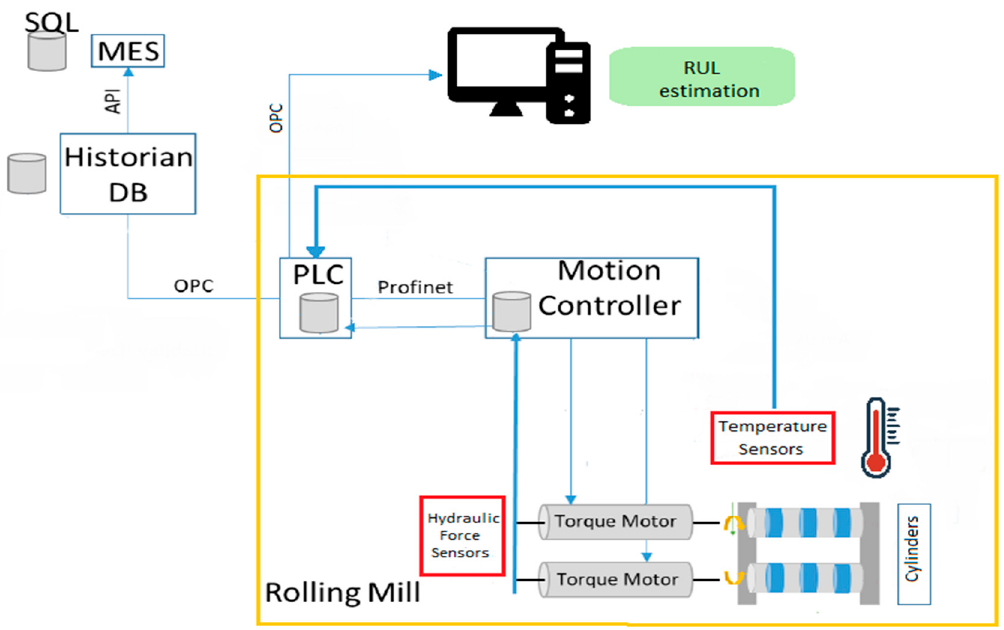
Figure 5. Data connections.